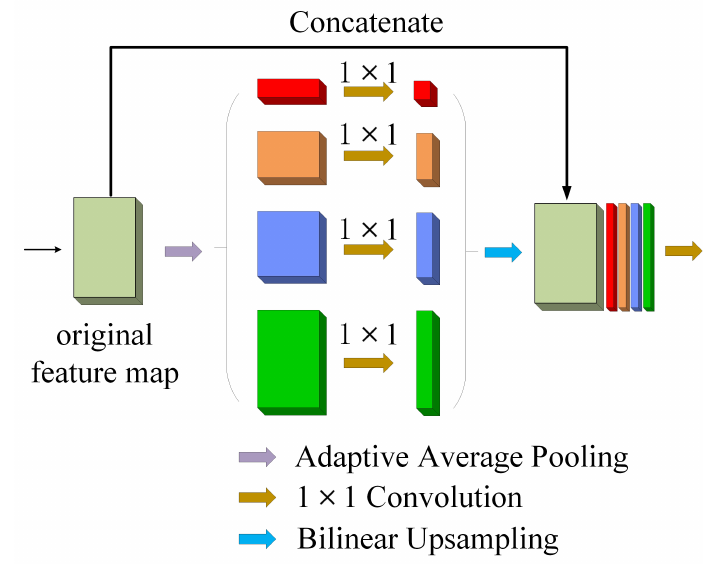
Figure 6. The pyramid pooling module